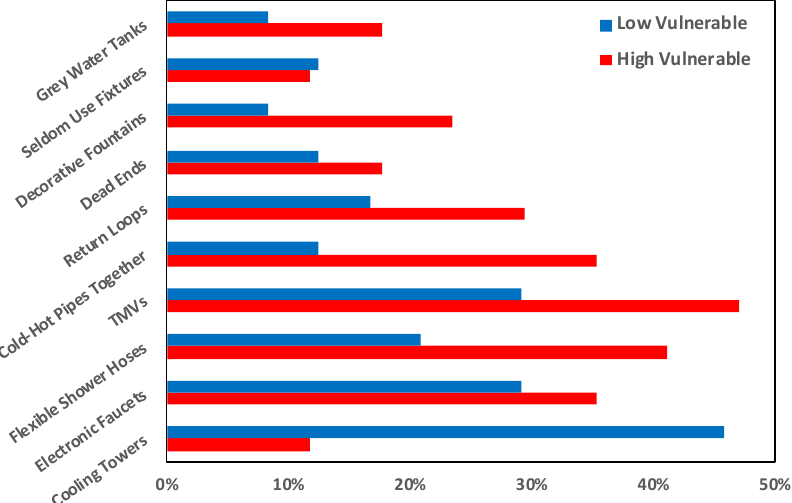
Figure 3. Frequency of different features in building plumbing systems identified in facility managers’ survey.